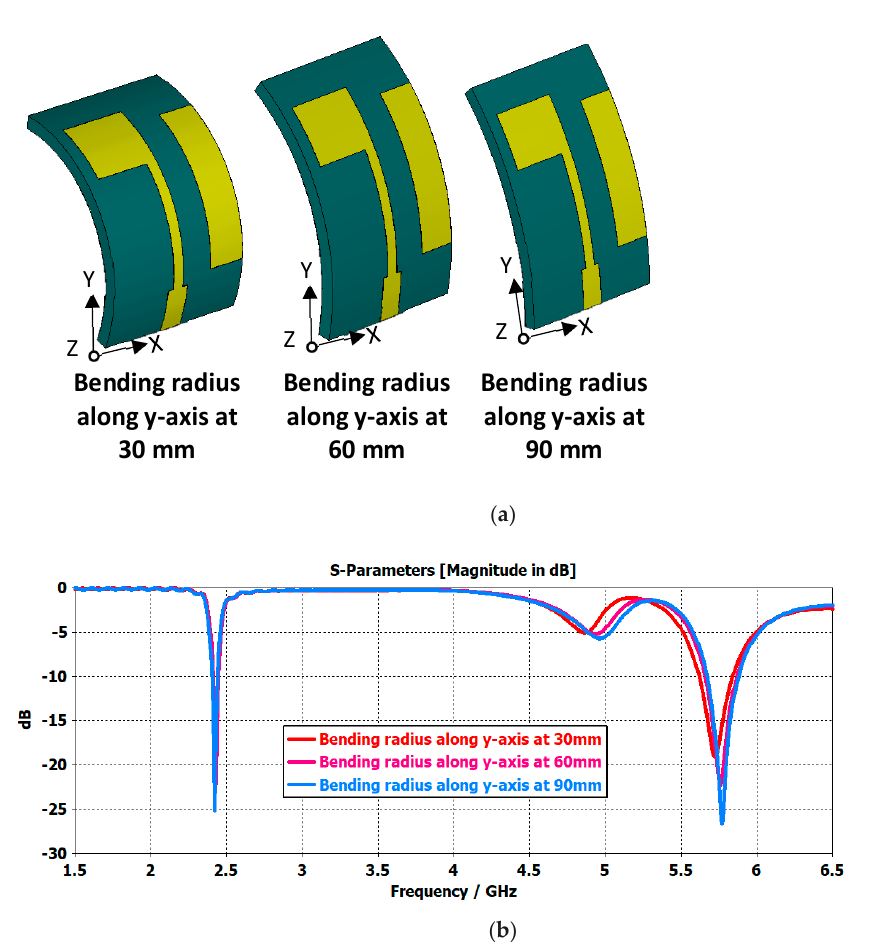
Figure 8. ( a ) Bending analysis of the antenna along the y -axis; ( b ) S 11 behavior at By = 30, 60, and 90 mm.